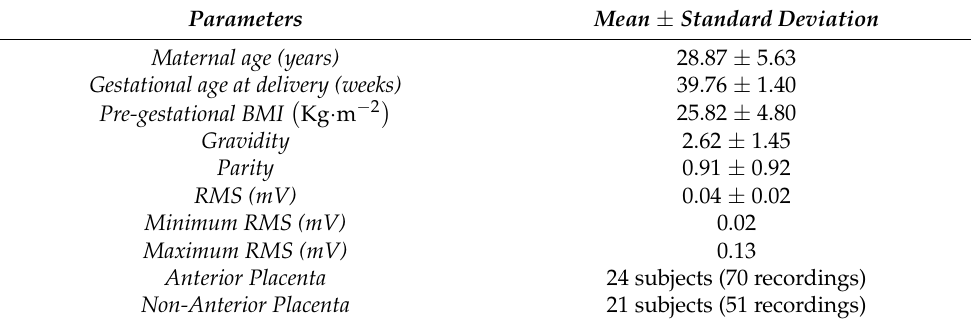
Table 1. The Iceland Database